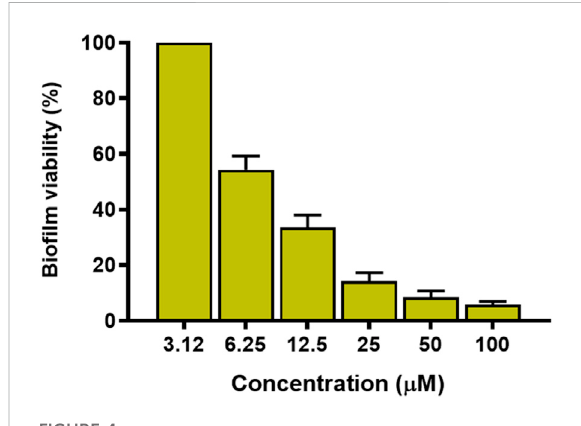
FIGURE 4 Metabolic activity of P. aeruginosa ATCC 27853 bio fi lm after treatmentwithKDEONWK-11 atconcentrationsof3.12,6.25,12.5, 25, 50 and 100 μ M for 2 h in PBS. Data represent the mean ± standard error of the mean (SEM) of three independent experiments.